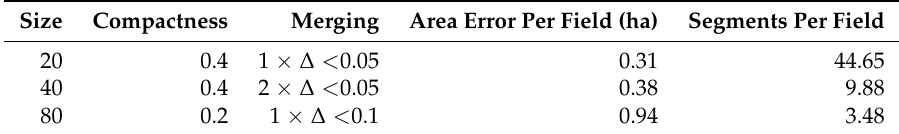
Figure 9. The average number of segments per field polygon geometry, as a function of ( a ) the SNIC segmentation size parameter, and ( b ) the average segment area error. Multiple segment merging settings are shown. For example, 2 × ∆ < 0.1 merges adjacent segments if the mean NDVI difference across all months is less than 0.1, with two iterations. Table 4. Area error and number of segments per field geometry for selected sets of SNIC segmentation and merging paramters. The parameters in the middle row were